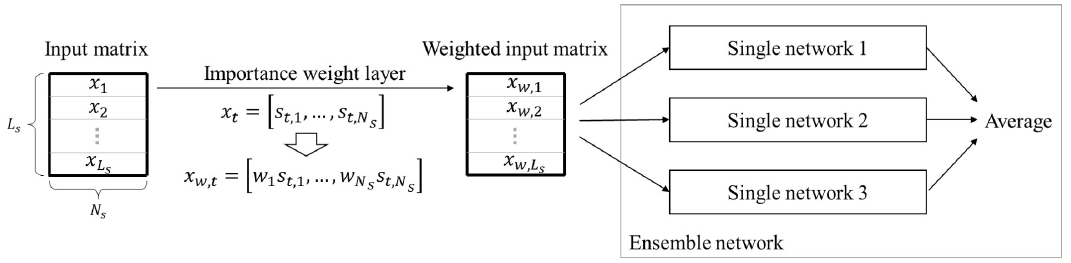
Figure 5. Structure of the ensemble network with importance weight